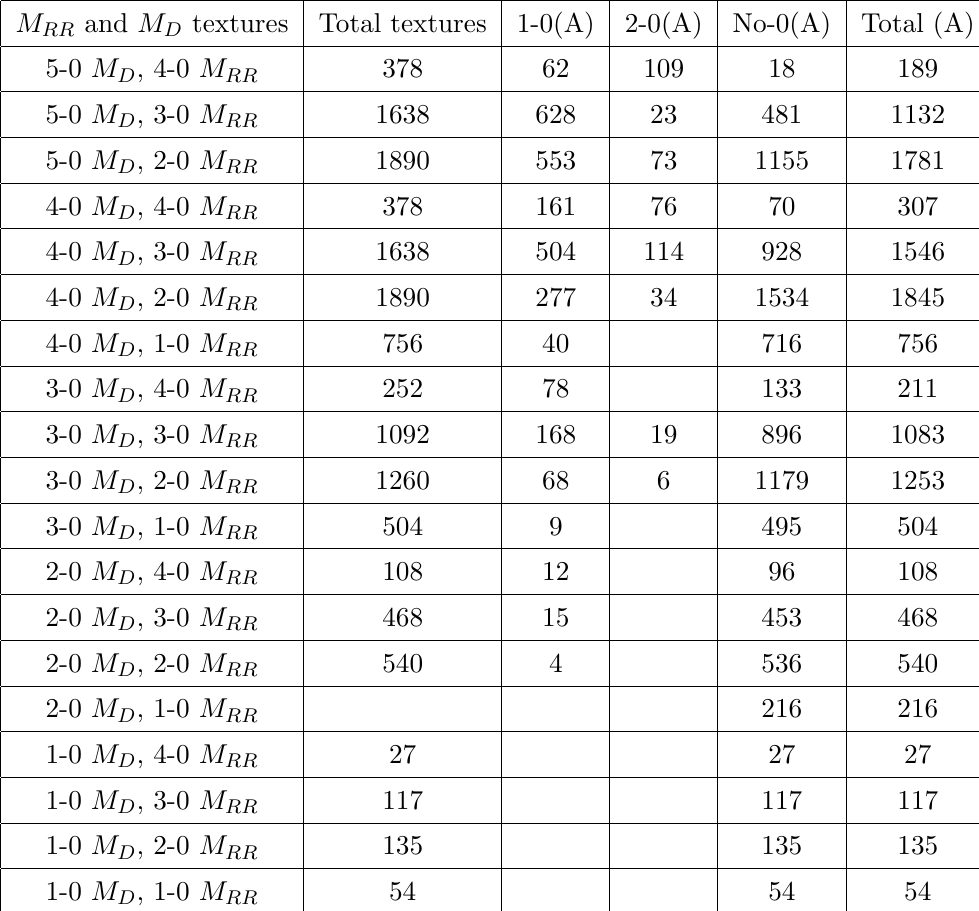
Table 1 . Di(cid:11)erent number of allowed (A) texture zero neutrino mass for di(cid:11)erent textures of M D and M RR . The blank boxes mean no possibilities.